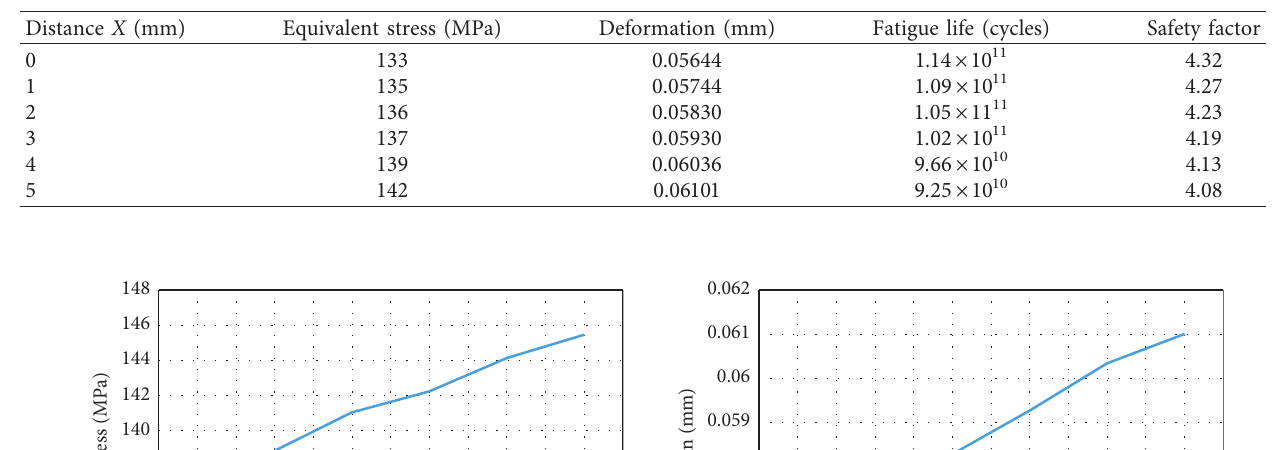
Table 1: Results obtained for the chain link without a modeled